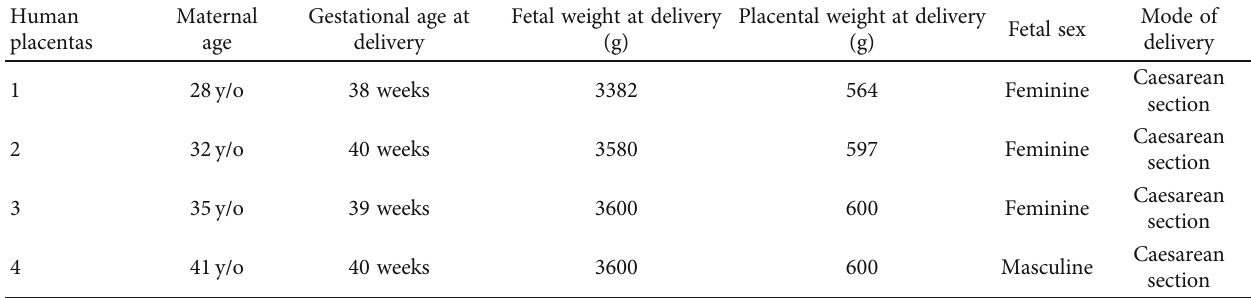
Table 1: Maternal age, gestational age at delivery, fetal and placental weights at delivery, fetal sex, and mode of